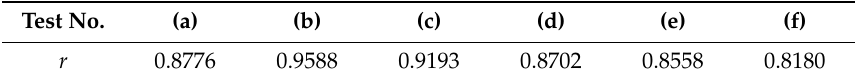
Table 8. The correlation coe ffi cients between measured and predicted results.